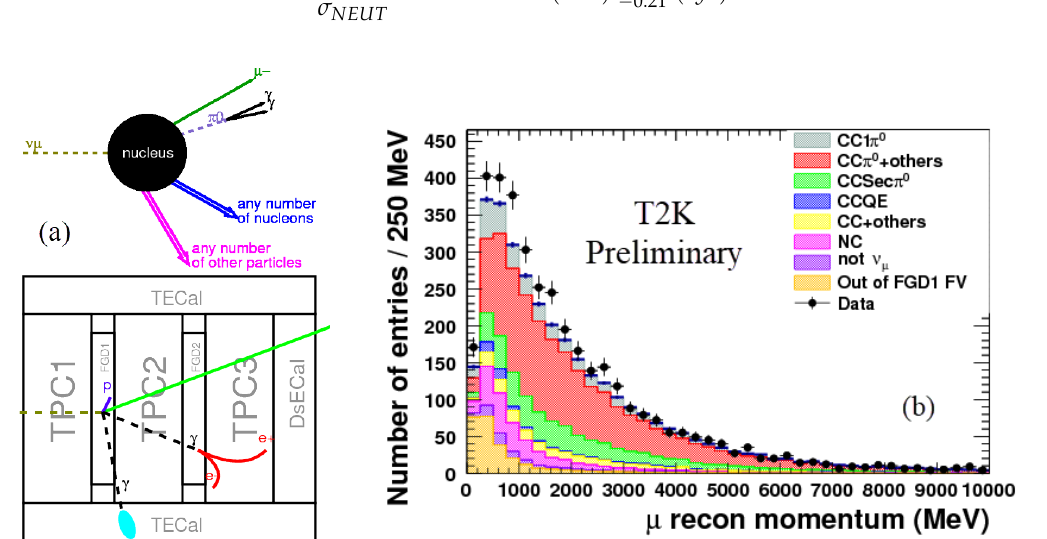
Figure 3. π 0 production in muon–neutrino charged current interactions is measured by the T2K near detector, ND280. ( a ) An illustration of the criteria applied to select a sample enhanced with CC π 0 events and a typical topolgy of these events in ND280; ( b ) Observed µ − spectrum (points) compared to the NEUT model predictions broken down by interaction